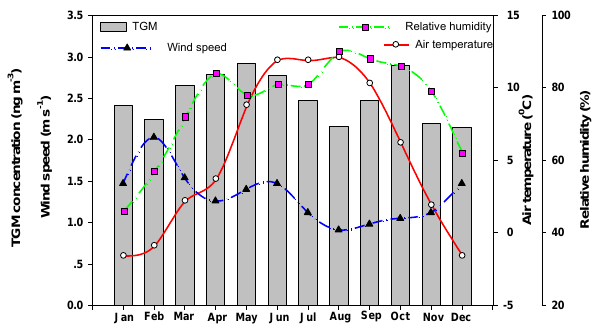
Figure 5. The variation in the monthly means of TGM, WS, AT and RH. TGM concentration is high in the ISM period with high AT and RH.